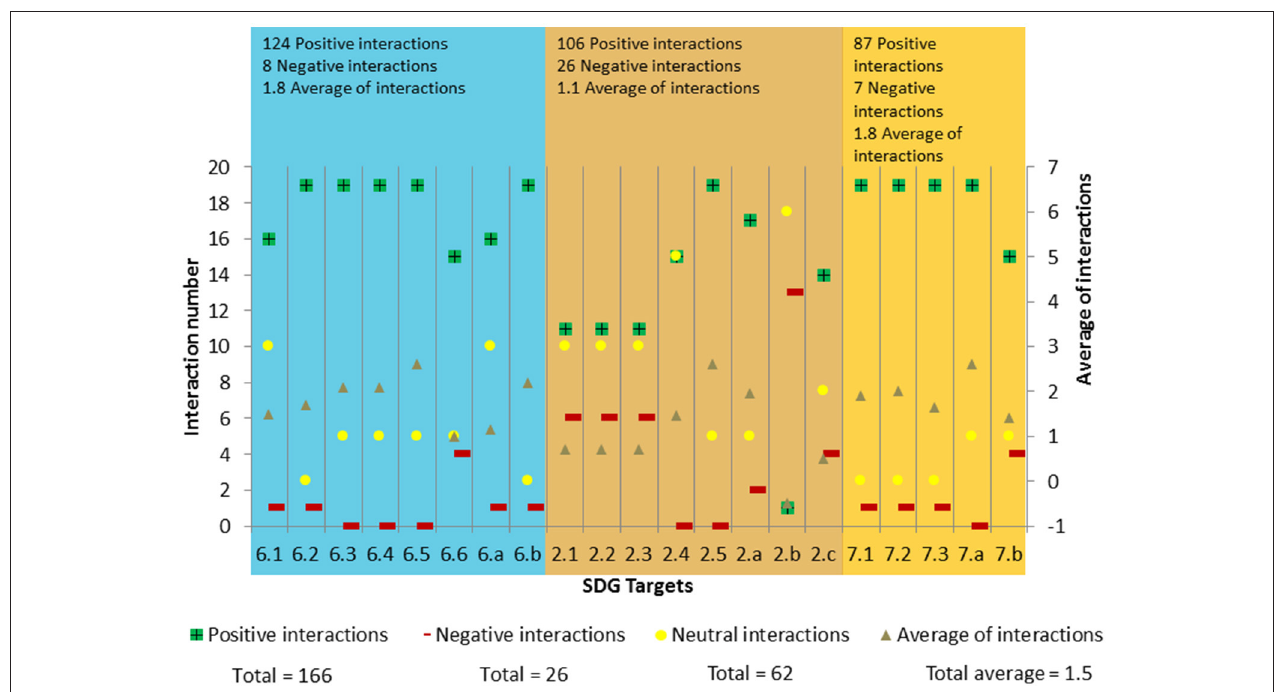
FIGURE 2 | Interaction number (positive, neutral and negative) (left y-axis) and average of total interaction value ( TIS ) (right x-axis) for SDG targets of the water (blue), food (orange) and energy (yellow) goals (x-axis). The values written on the upper part of the graph correspond to total positive, negative and average of interactions per SDG. The values below the legend represent the total number of positive, negative, neutral interactions, and average of interactions, for all SDG targets taken